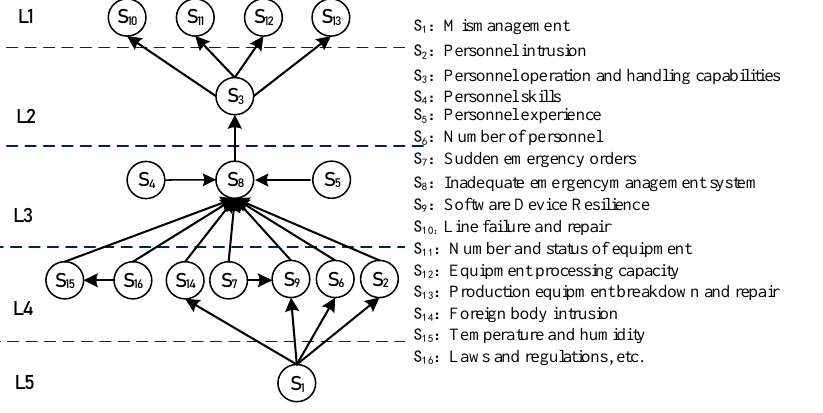
Figure 7. Multi-level recursive interpretative structural model of the brittleness of lean–green manufacturing systems in the context of Industry 4.0.